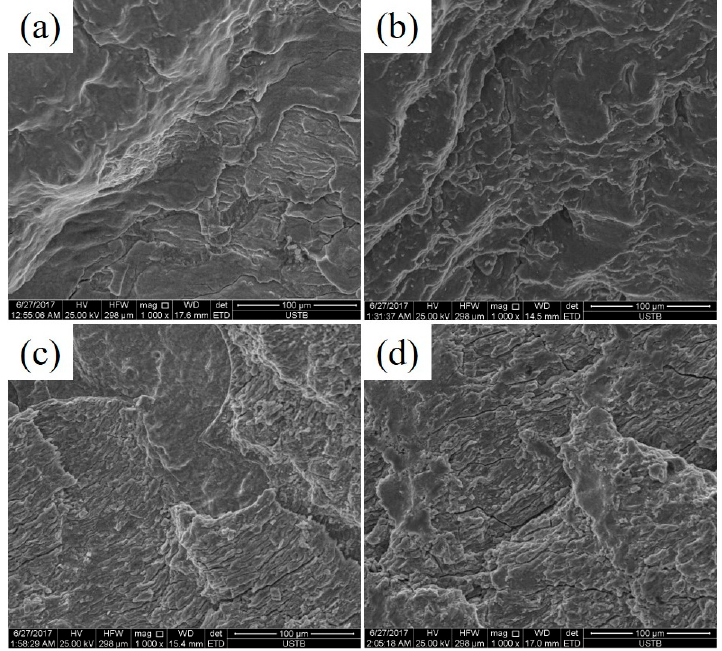
Figure 13. Typical morphologies of propagation zone at different strain amplitudes, novel steel: ( a ) 0.2% and ( b ) 0.6%, and 30SiMn2MoV: ( c ) 0.2% and ( d ) 0.6%.